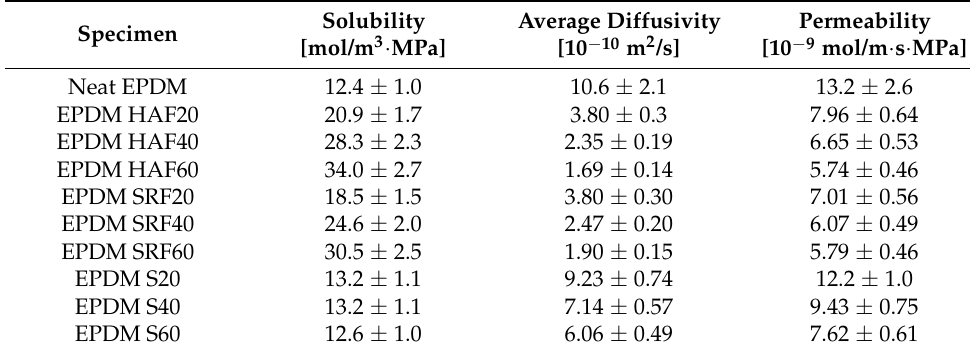
Table 3. Summary of H 2 permeation parameters for EPDM